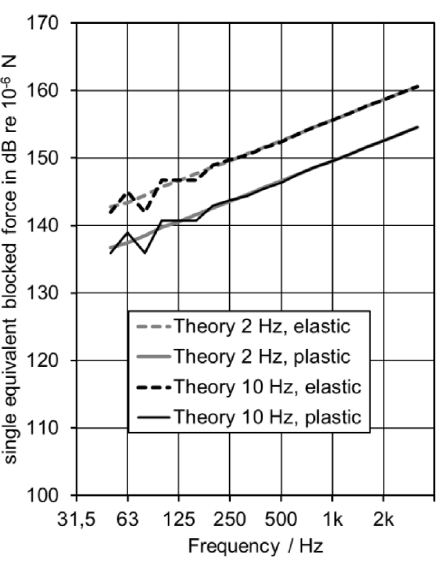
Figure 9. Range of theoretically expected equivalent blocked force levels in one-third octave bands calculated for a 2 Hz and a 10 Hz line spectrum and for elastic impacts ( v 0 = v max ) and max plastic impacts ( v 0 = 0). max